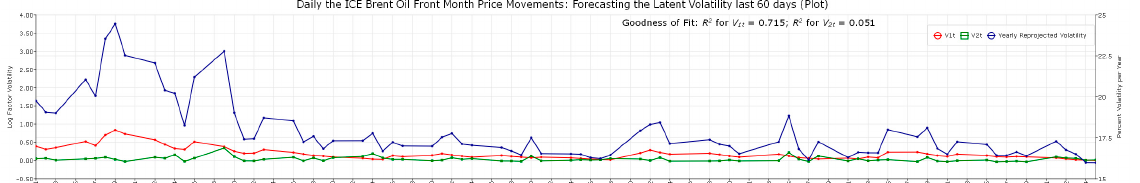
Figure 3. Daily Conditional Volatility from Observables and Kalman Filtered Volatility .